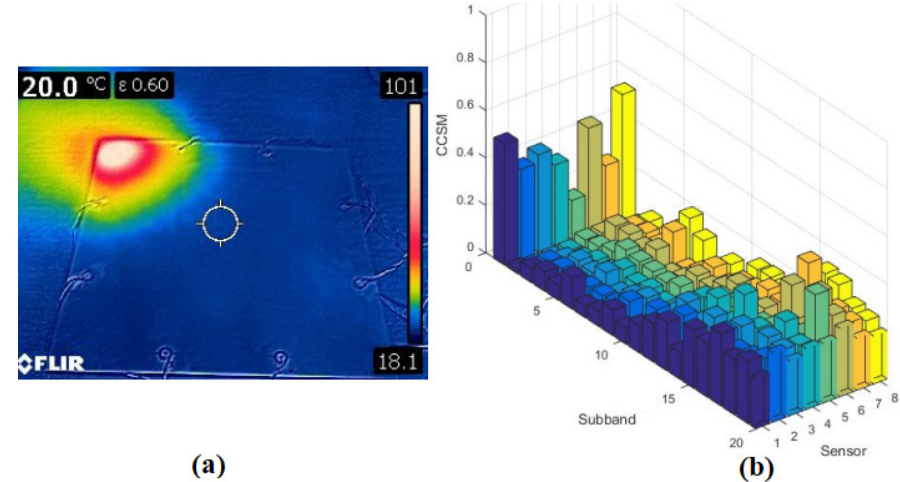
Figure 4. ( a ) Thermal image of the heated plate in one of the corners between Sensors 6 and 7; ( b ) CCDM indices calculated after compensation with the EFS method.